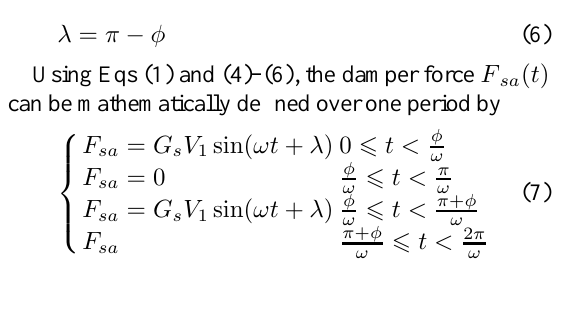
Fig. 6. Typical magneto rheological damper force characteristics for different